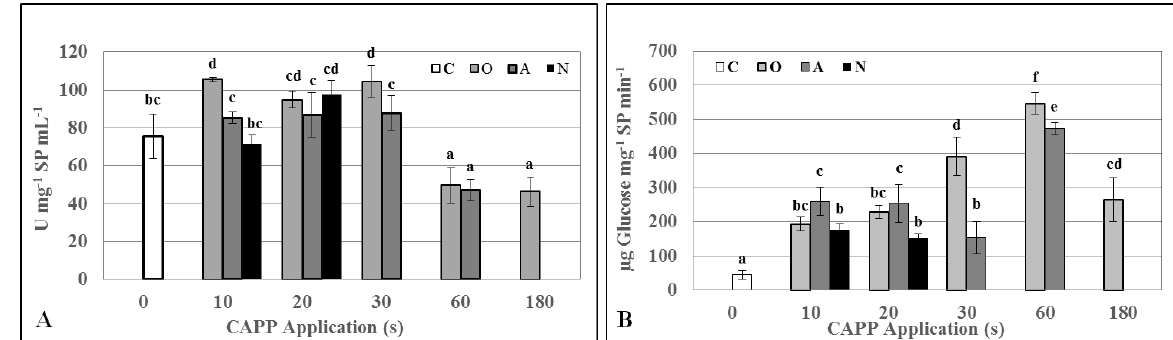
Figure 3. Activities of protease ( A ) and glucanase ( B ) in 3-day old barley seedlings after CAPP treatment. Variants: C—control/untreated barley grains; O10–O300: barley grains treated with plasma generated in oxygen atmosphere for 10, 20, 30, 60, 180 or 300 s; A10–A300: barley grains treated with plasma generated in ambient air for 10, 20, 30, 60, 180 or 300 s; N10–N300 barley grains treated with plasma generated in nitrogen atmosphere for 10, 20, 30, 60, 180 or 300 s. Different letters indicate significant difference at p- value < 0.05, bars are means of ten experimental runs (one run represents 50 seeds per variant; three 1.5-g mixed samples were analyzed per experimental run and each variant for protease and glucanase activities) ± SD according to Tukey’s HSD test.